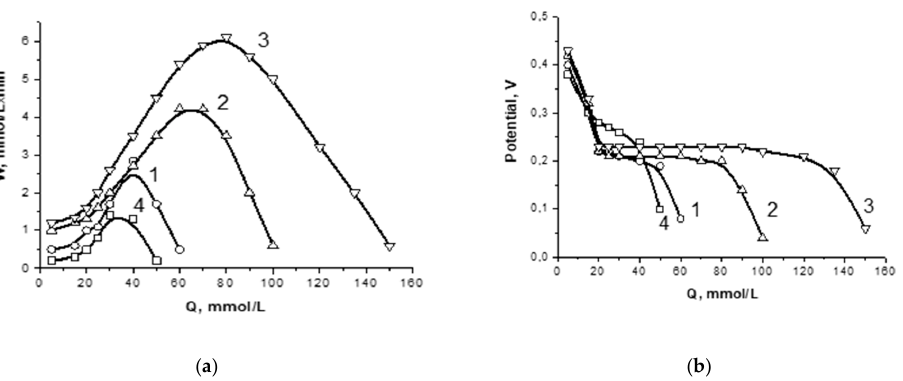
Figure 1. Kinetic ( a ) and potentiometric ( b ) curves of PH 3 oxidation by aqueous copper–ammonia complexes at t = 50 °C, X(PH 3 ) = 98–99%, C РН 3in = 10,000 mg/m 3 , solution composition, mol/L: